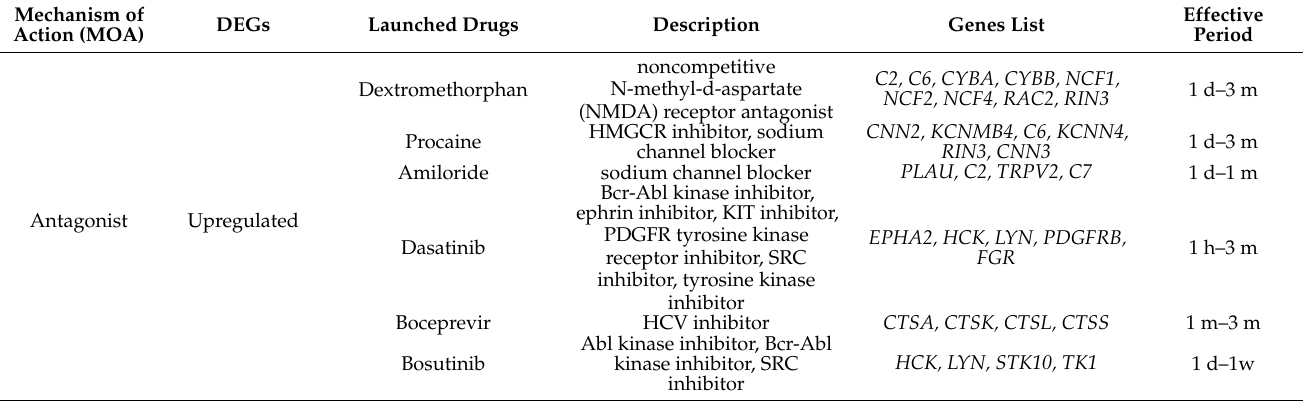
Table 1. List of potential therapeutic drugs interacting with the significant DEGs in